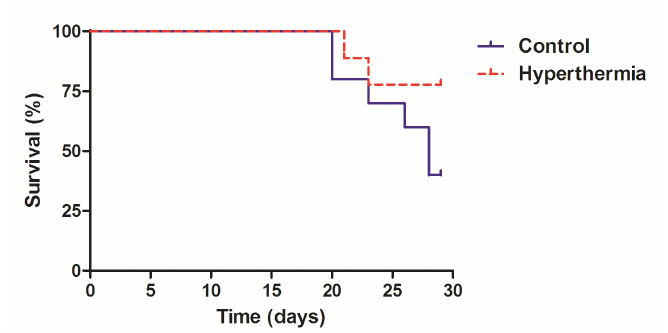
FIGURE 4 – Survival curves - Control and Hyperthermia Groups (Kaplan-Meier method). Data expresses percentage of live animals during the experiment. Comparisons between groups were made by log-rank test. Values were not significantly different (P= 0.1355). Mean survival: 28 days (Control Group) and not defined (Hyperthermia